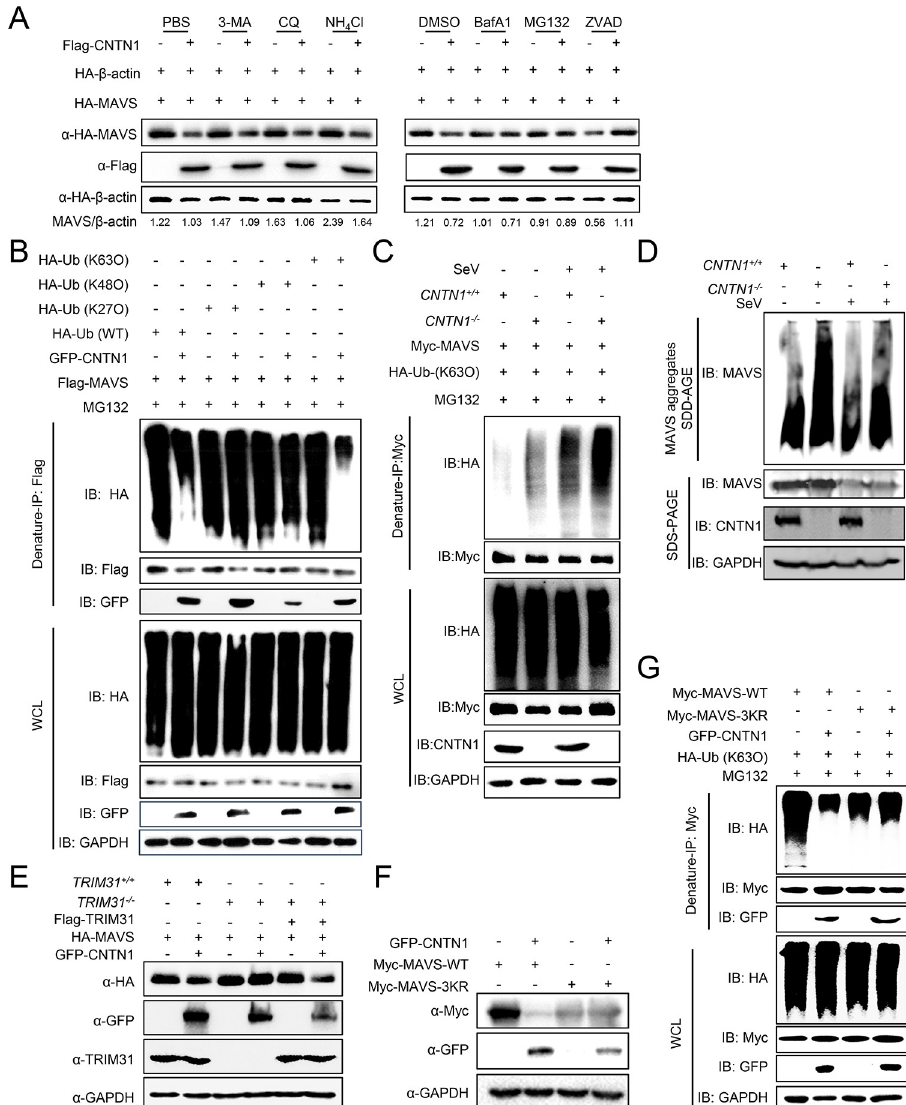
Fig 5. CNTN1 promotes proteasomal degradation of MAVS. (A) MG132 and ZVAD blocks CNTN1-mediated MAVS degradation. HEK293 cells were transfected with the indicated plasmids for 20 h and then treated with 3-MA (10 mM), CQ (50 μ M), NH 4 Cl (20 mM), MG132 (10 μ M), BafA1 (0.2 μ M), or ZVAD (20 μ M) for 6 h. The cell lysates were then analyzed by immunoblotting with the indicated antibodies. The intensities of the indicated protein bands were determined by image J, normalized to HA- β -actin, and are shown as the fold-change of MAVS/ β -actin. (B) CNTN1 inhibits K63-linked ubiquitination of MAVS. HEK293 cells transfected with Flag-MAVS, HA-ubiquitin, or its mutants [KO, in which all but one of the lysine residues were simultaneously mutated to arginine (K-only)], together with a control or CNTN1 plasmids, were pre-treated with MG132 for 6 h. The cells were then subjected to denature- immunoprecipitation (denature-IP) and immunoblotting analysis with the indicated antibodies. (C) CNTN1 +/+ and CNTN1 -/- cells were transfected with Myc-MAVS, HA-ubiquitin (K63O), and were left uninfected or infected with SeV for 12 h. The cells were then subjected to denature-IP and immunoblotting analysis with the indicated antibodies. (D) CNTN1 +/+ and CNTN1 -/- cells were left uninfected or infected with SeV for 12 h. Twenty-four hours later, cells were harvested for SDD-AGE or SDS-PAGE followed by immunoblotting analysis with the indicated antibodies. (E) TRIM31 deficiency inhibits CNTN1 mediated degradation of MAVS. Wild-type HEK293 cells or TRIM31-deficient cells were transfected with the indicated plasmids for 24 h, followed by immunoblotting analysis with the indicated antibodies. (F) HEK293 cells transfected with GFP-CNTN1 and wild-type MAVS or the MAVS 3KR mutant (K11, 311, and 461R) for 24 h before immunoblotting analysis. (G) CNTN1 does not inhibit K63-linked ubiquitination of the MAVS 3KR mutant. HEK293 cells transfected with wild-type MAVS or the MAVS 3KR mutant, HA-ubiquitin (K63O), together with a control or CNTN1 plasmids, were pre-treated with MG132 (10 μ M) for 6 h. The cells were then subjected to denature-IP and immunoblotting analysis with the indicated